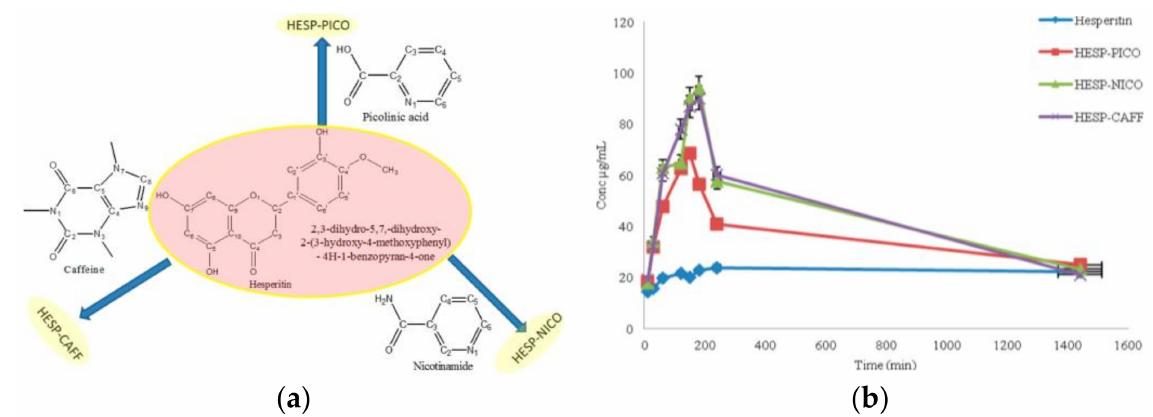
Figure 26. ( a ) The effect of co-crystallization on the dissolution rate for co-crystals of hesperetin with picolinic acid, nicotinamide, and caffeine. ( b ) Equilibrium solubility (24 h) of hesperetin, HESP-PICO, HESP-NICO, and HESP-CAFF. Reprinted with permission from Ref. [89]. 2017, American Chemical Society.